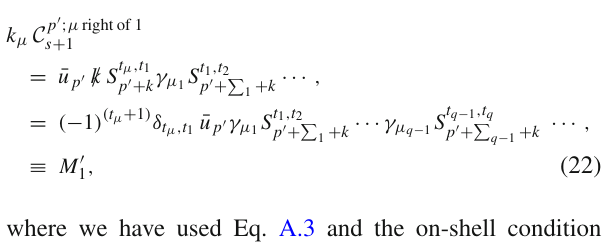
Fig. 5 Set of ( s + 1 ) diagrams showing all possible insertions of a virtual photon at vertex μ on the p (cid:6) leg of a fermion/scalar which already has s vertices. Here the left-most (shaded) vertex is the vertex V , and the p leg is not